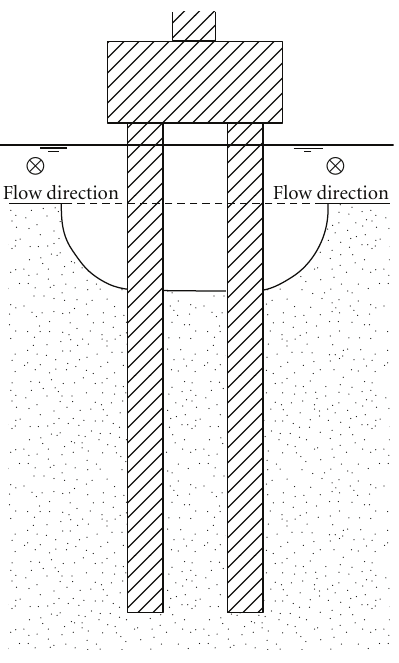
Figure 2: Pile group configuration used in experimental campaign.